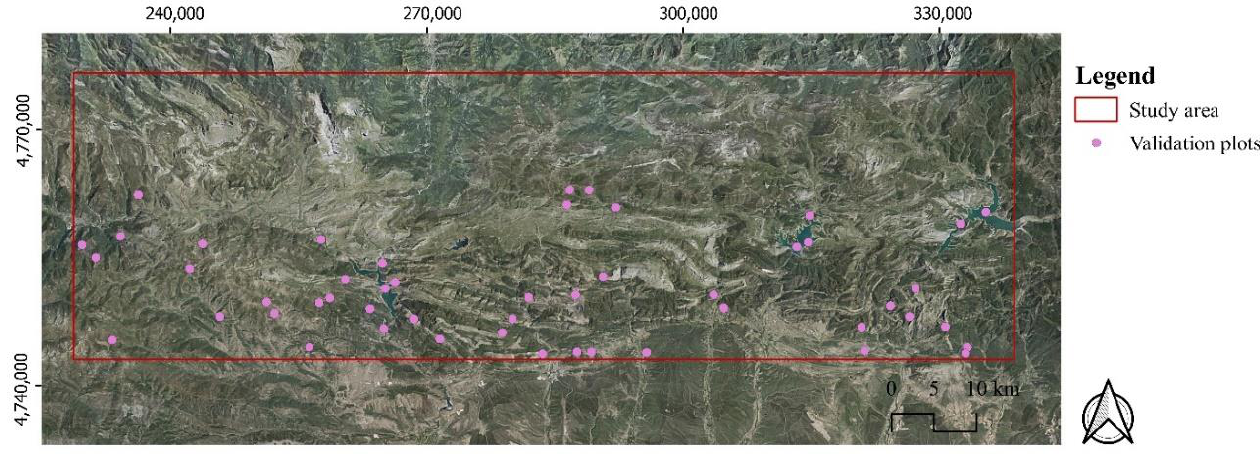
Figure A1. Distribution of validation plots in the study area. Table A1. Table of results obtained from the MESMA fraction images after normalization of the shade showing the number and proportion of pixels for each class model (W = water; F = forest; S = shrubland; G = grassland; R = rock and bare soil).